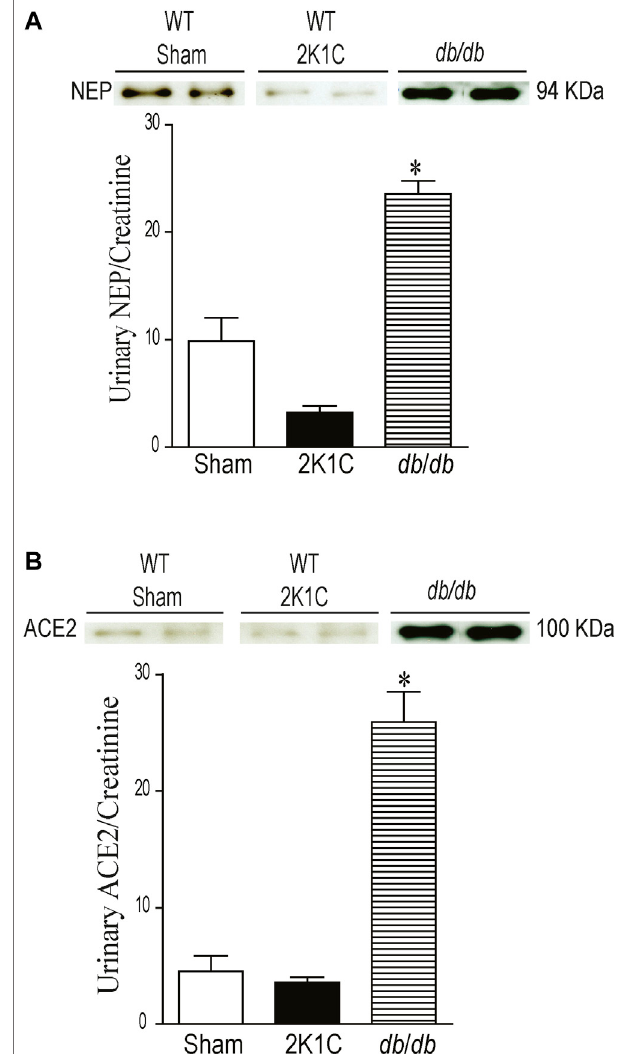
FIGURE 10 | Urine volumes equivalent to 0.75 µg creatinine was used for western blot analysis of urinary ACE2 (A) and NEP (B) expression in WT mice. Urine samples from db / db diabetic mice was used as positive controls. In each individual experiment, samples were loaded randomly in four gels.TwoImmunoreactivebandsfromeachgroupcorrespondingtoNEPand ACE2 were appropriately cropped and spliced as a representative of the result. In db / db mice, ACE2 was detected at 100 kDa, whereas only faint bandsforACE2weredetected intheurineofshamand after2K1Csurgery.In db / db and WT(Sham)mice,fulllengthNEP wasdetectedat94 kDa,whereas decreased expression of NEP was detected in the urine of WT mice after 2K1C surgery. * p < 0.001vs.WT (sham), Eachbar representsmean ± SEM(n (cid:2) 6 –